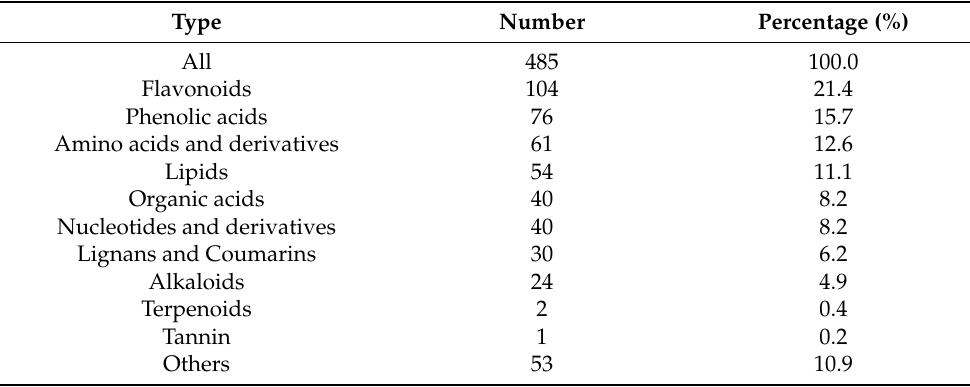
Table 6. Metabolite identification table of water